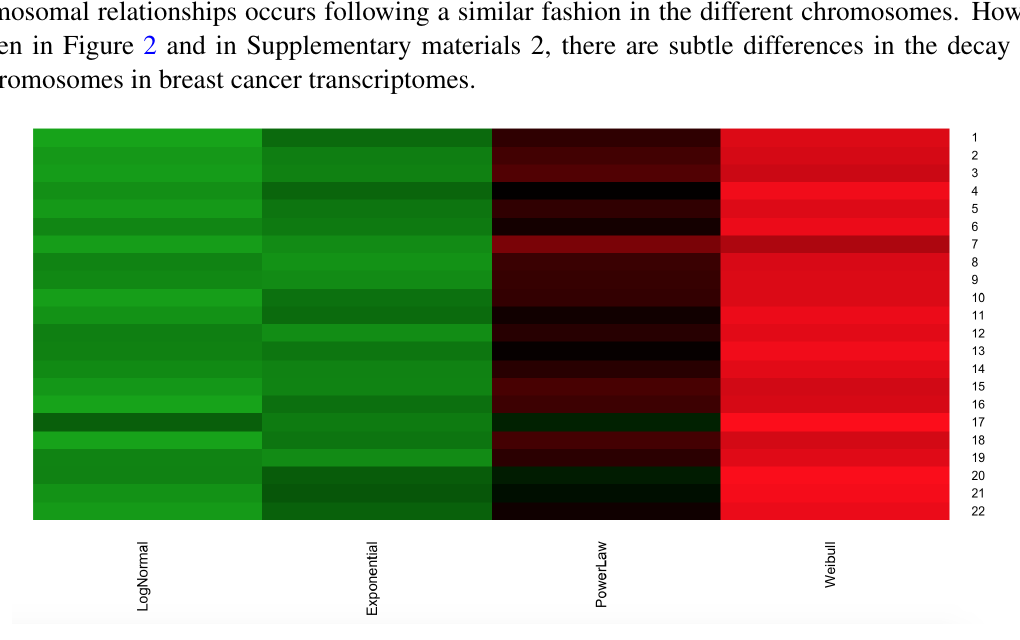
Fig. 2 Model validation. A heatmap depicting Z-scored relative likelihood – as measured by adjusted coefficient of determination R2 – for the four models. Rows correspond to chromosomes, while columns correspond to the four models for nonscaled distance. Green tones correspond to low-to-negative scores, while the dark and red colours represent positive-to-high